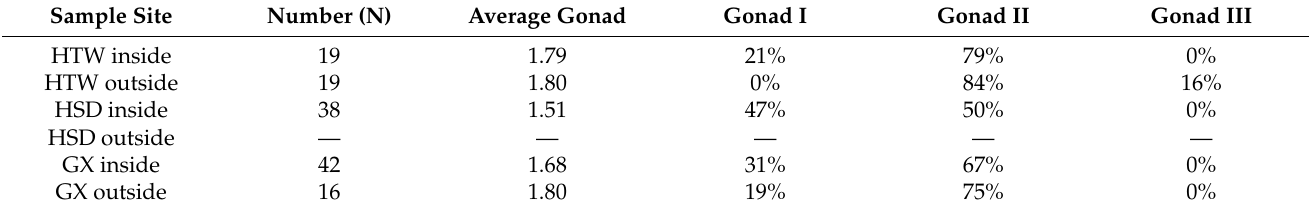
Table 2. The number (unit: individuals) and the gonad maturity (I–III) of Sebastiscus marmoratus in Houtouwan (HTW), Huangshidong (HSD), and Ganxie (GX) inside and outside the Sargassum horneri